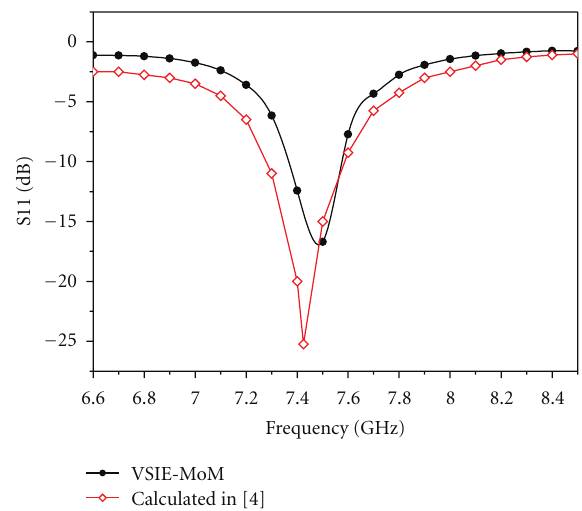
Figure 3: S -parameter of the microstrip patch antenna solved by MoM based VSIE solver, and compared with the results calculated in